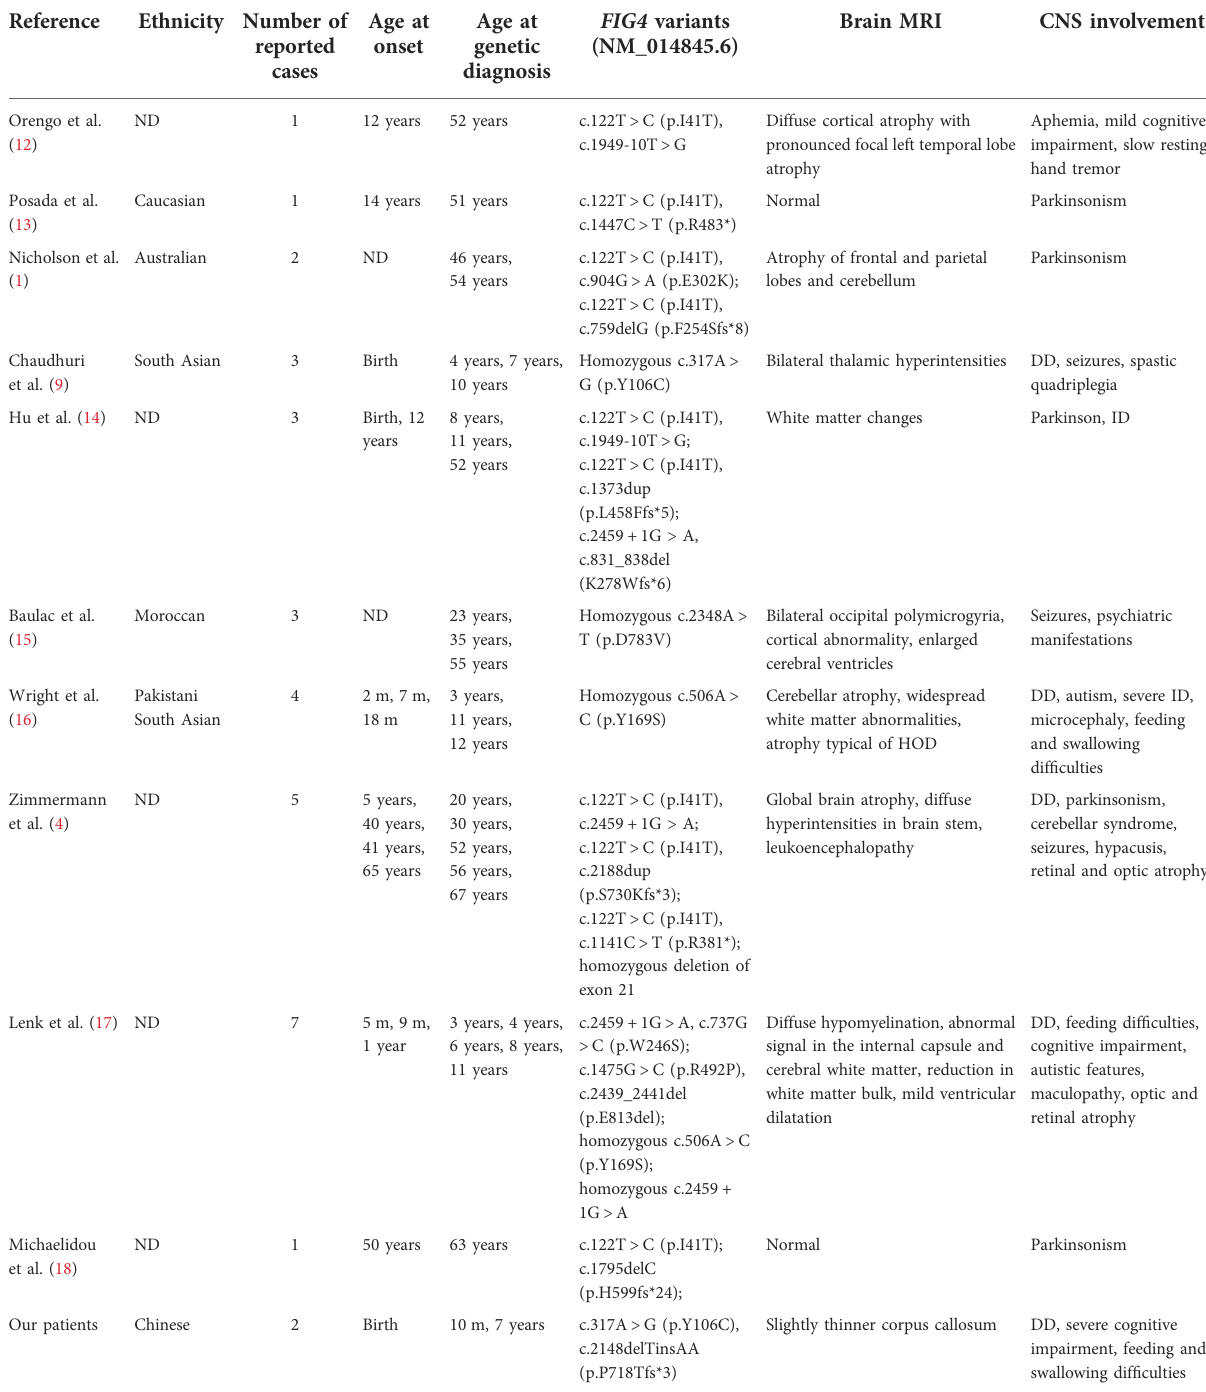
TABLE 2 CMT4J cases with CNS